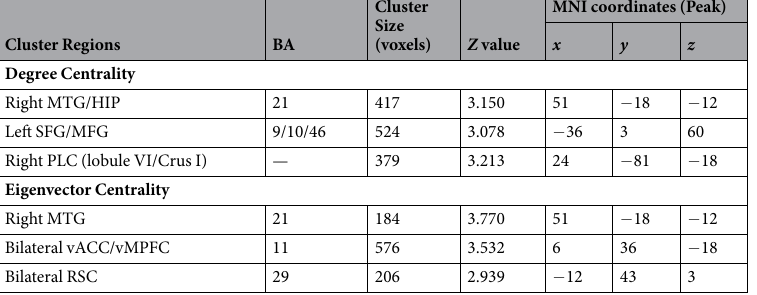
Table 2. Diagnosis-by-genotype interactions on degree centrality and eigenvector centrality. Abbreviations: MTG, middle temporal gyrus; HIP, hippocampus; SFG, superior frontal gyrus; MFG, middle frontal gyrus; PLC, posterior lobe of cerebellum; vACC/vMPFC, ventral anterior cingulate/ventral medial prefrontal cortex; RSC, retrosplenial cortex; BA, Brodmann area; and MNI, Montreal Neurological